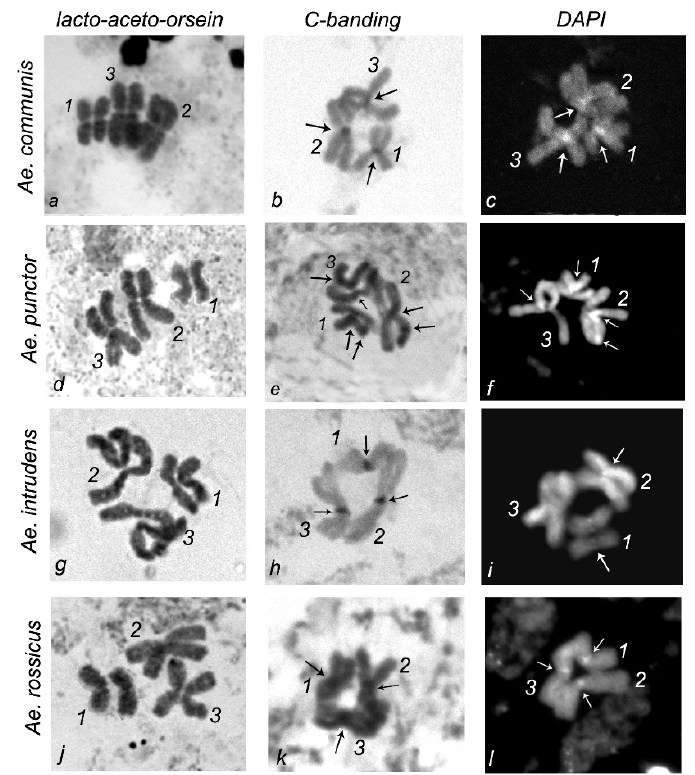
Figure 2. Metaphase chromosomes in the imaginal discs of ( a – c ) Ae. communis , ( d – f ) Ae. punctor , ( g – i ) Ae. intrudens , and ( j – l ) Ae. rossicus: ( a , d , g , j ) lacto-aceto-orcein staining; ( b , e , h , k ) C-staining; and ( c , f , i , l ) DAPI staining; arrows denote C- and DAPI bands.